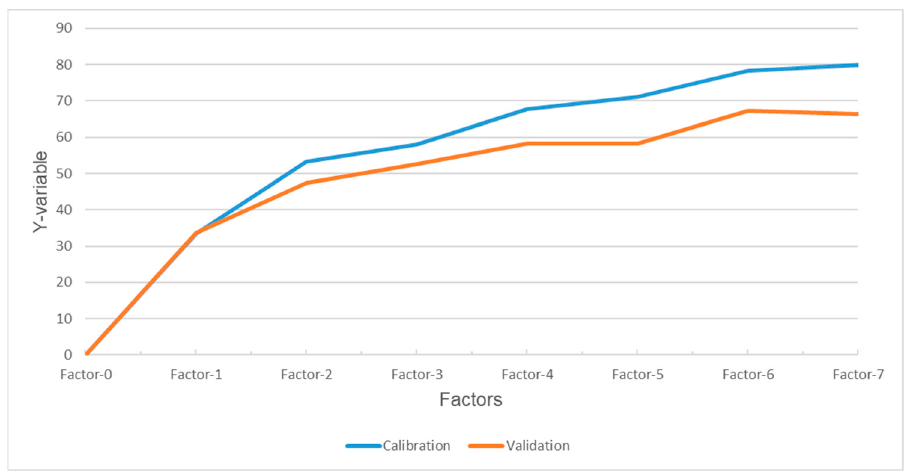
The explained variance plot of the SNV method is shown in Figure 8. The number of factors/components increased in the PLS compared with the PCA, as the prior only have three prediction levels (low, medium, and high) compared with the PLS where the model will predict the K nutrient levels (1.3%~3.2%), as presented in the laboratory results. The number of factors suggested by the model were six, where there were only two for the PCA as shown in Figure 8.